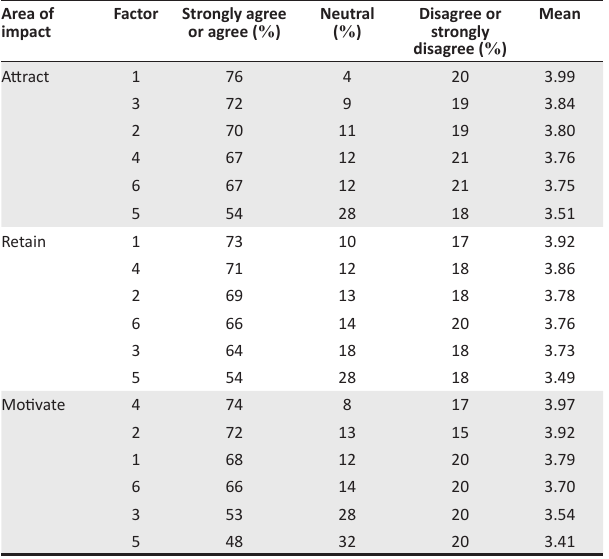
TABLE 3: The impact of the reward categories on organisations’ ability to attract, retain and motivate employees. Area of Factor Strongly agree impact or agree ( % )